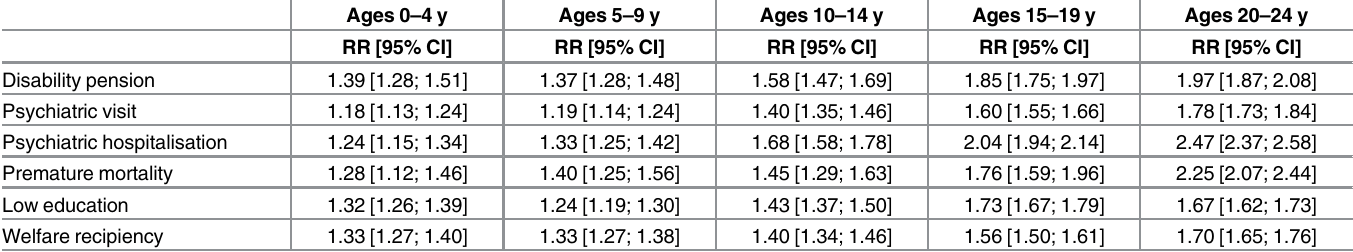
Table 7. Relative risks (RR) and corresponding 95% confidence intervals (CIs) for the associations between TBI and poor functioning in adult- hood, across age-band at first